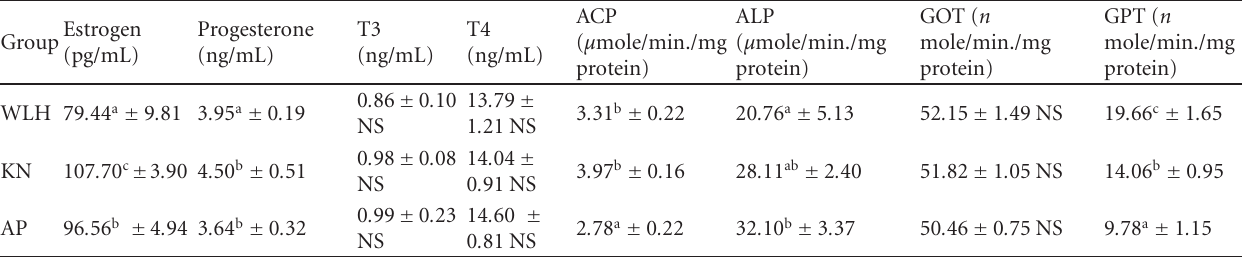
Table 5: Age-dependent variation in hormonal concentration and biochemical constituents of blood plasma (30thwk) in di ff erent breeds of Indian native hen (mean ± S.E.M, n =